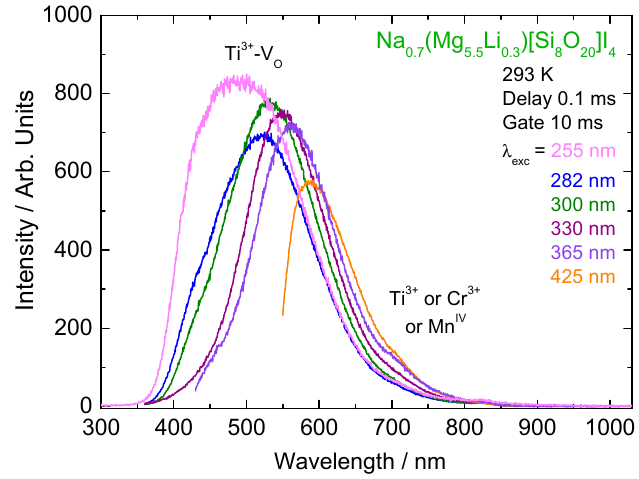
Figure A5. Emission spectra of iodohectorite recorded at several excitation wavelengths. The data are not corrected for the excitation source intensity at different wavelengths.